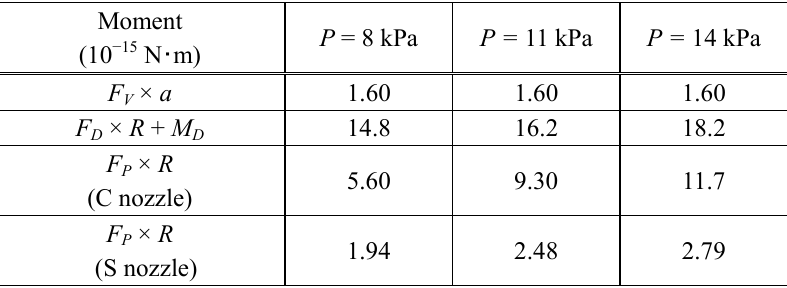
Table 3 Comparison of each moment for a 3.0 μ m